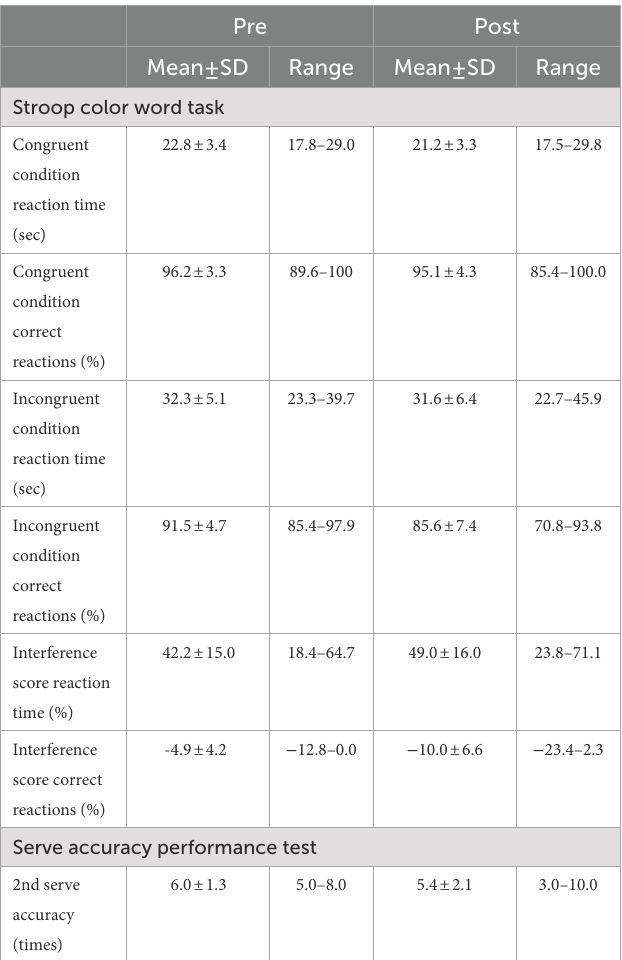
TABLE 1 The intensity of the exercise, result of SCWT, and second serve